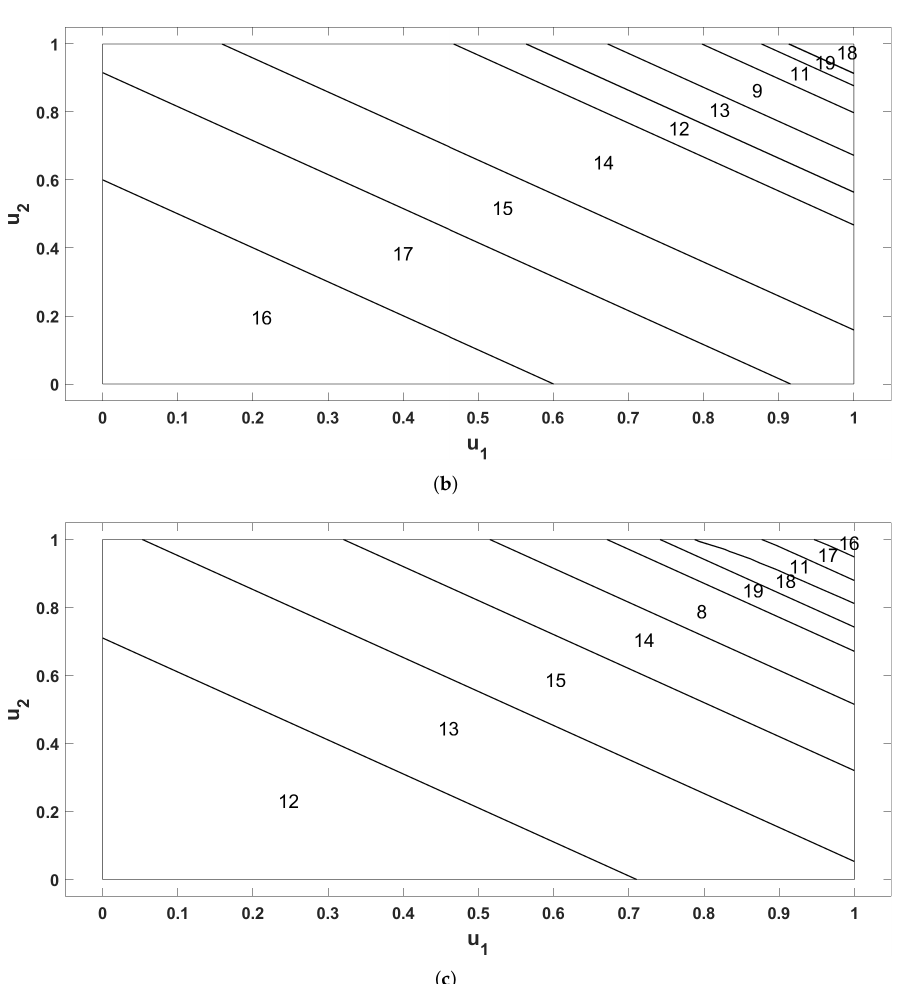
Figure 5. Complete partition plots for the optimization techniques. ( a ) Complete partition with NA. ( b ) Complete partition with EM algorithm. ( c ) Complete partition with PSO.